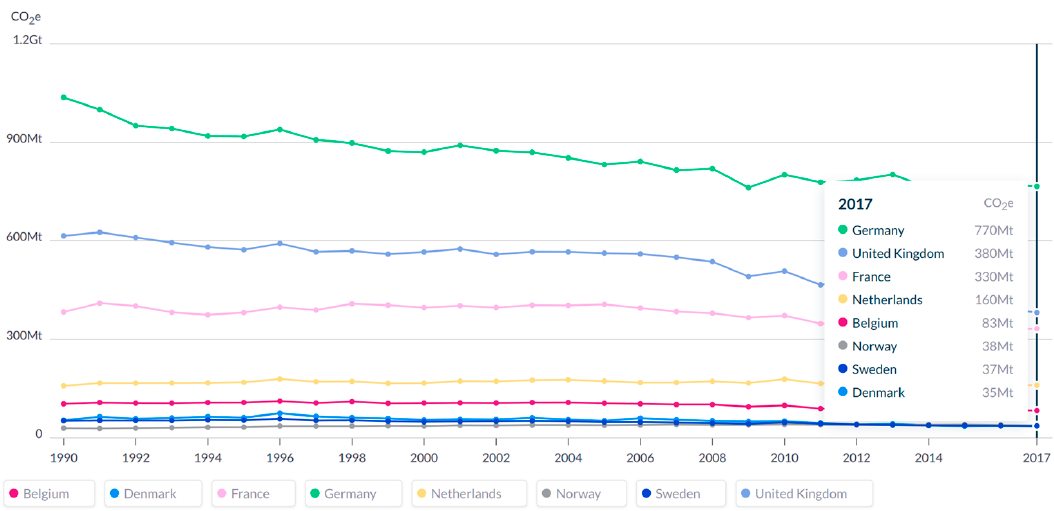
Figure 3. GHG emission in the energy sector by the NS countries (1990–2017). Adapted from [7,8].